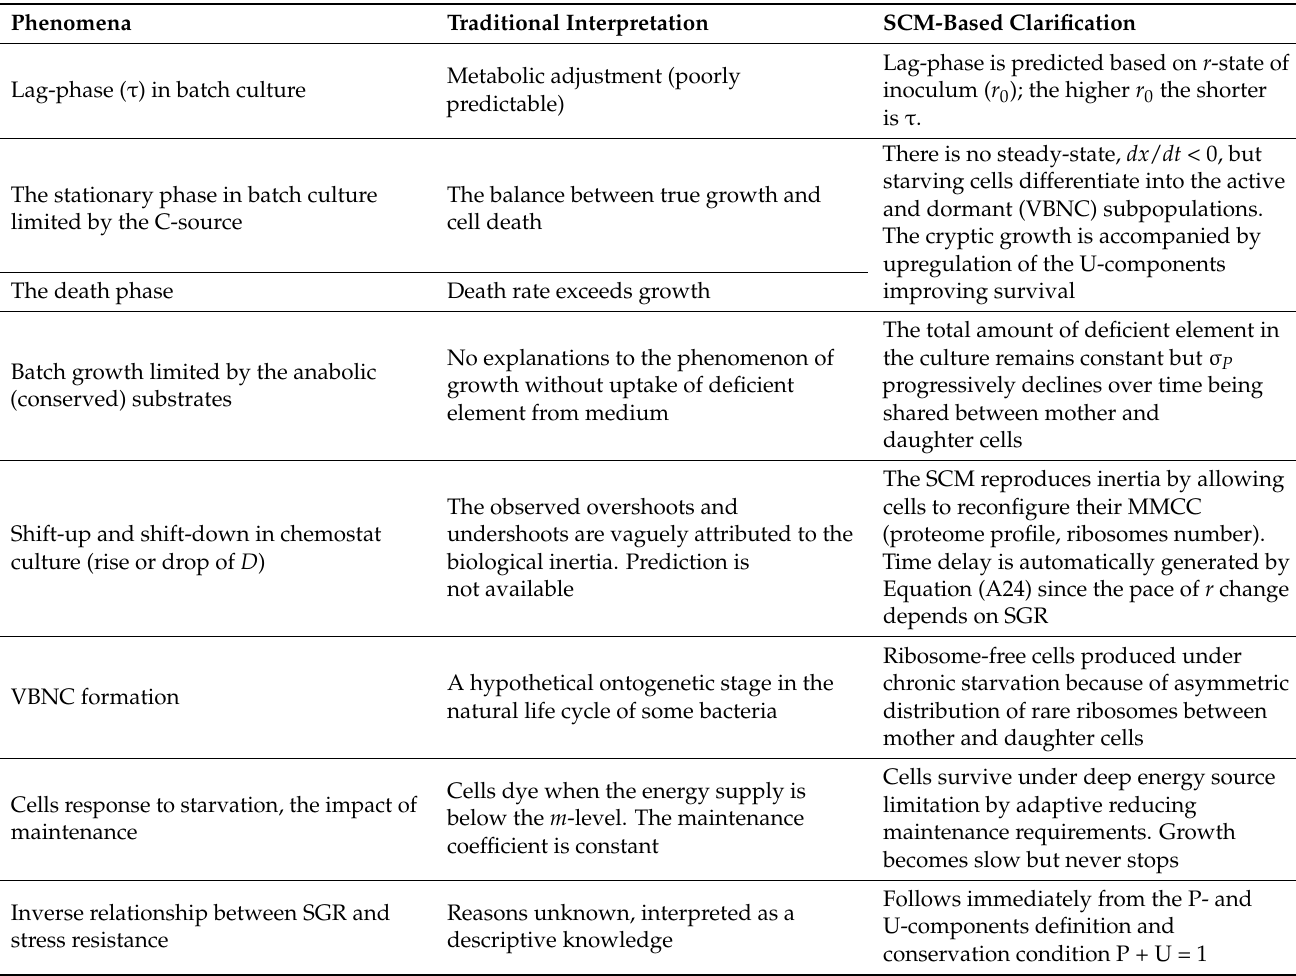
Table 3. Deciphering mechanisms controlling the unbalanced and non-steady-state growth